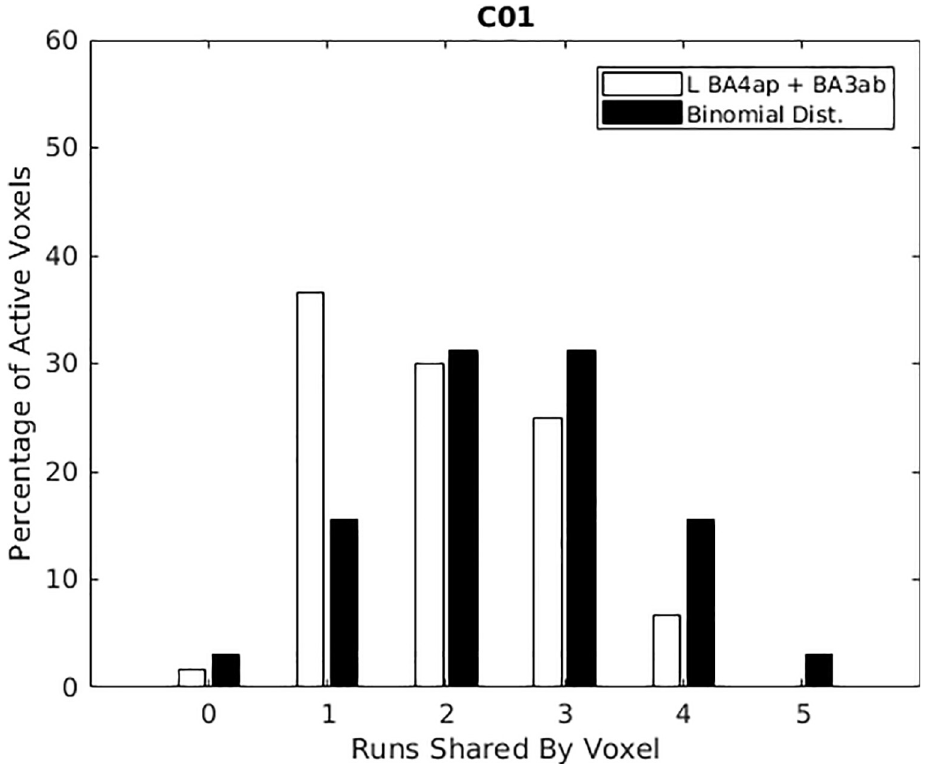
Fig 9. Histograms for left primary motor and somatosensory cortices combined. Ordinate height of the white bars represents a count of activated voxels (p < 0 .001 uncorrected; scaled as percentage of all voxels in the selected ROIs) that showed larger percent signal change during wrist extension than during wrist flexion. These counts are plotted as a function of the number of within-session data collection runs for which extension action preference was exhibited. Black bars show for comparison the corresponding binomial distributions that would be expected given randomly assigned mutually exclusive preference labels if no true preference for extension or flexion existed (i.e., the null hypothesis). Different panels present results for the 10 participants, ordered by participant ID left to right and top to bottom. Note a trend for white bars to be taller than black bars in the left half of the plots, white bars to be shorter than black bars in the right half of the plots. For five participants (C01, C02, C03, C04, C11), observed frequencies differed significantly from binomial distributions (Kolmogorov-Smirnov tests, p <